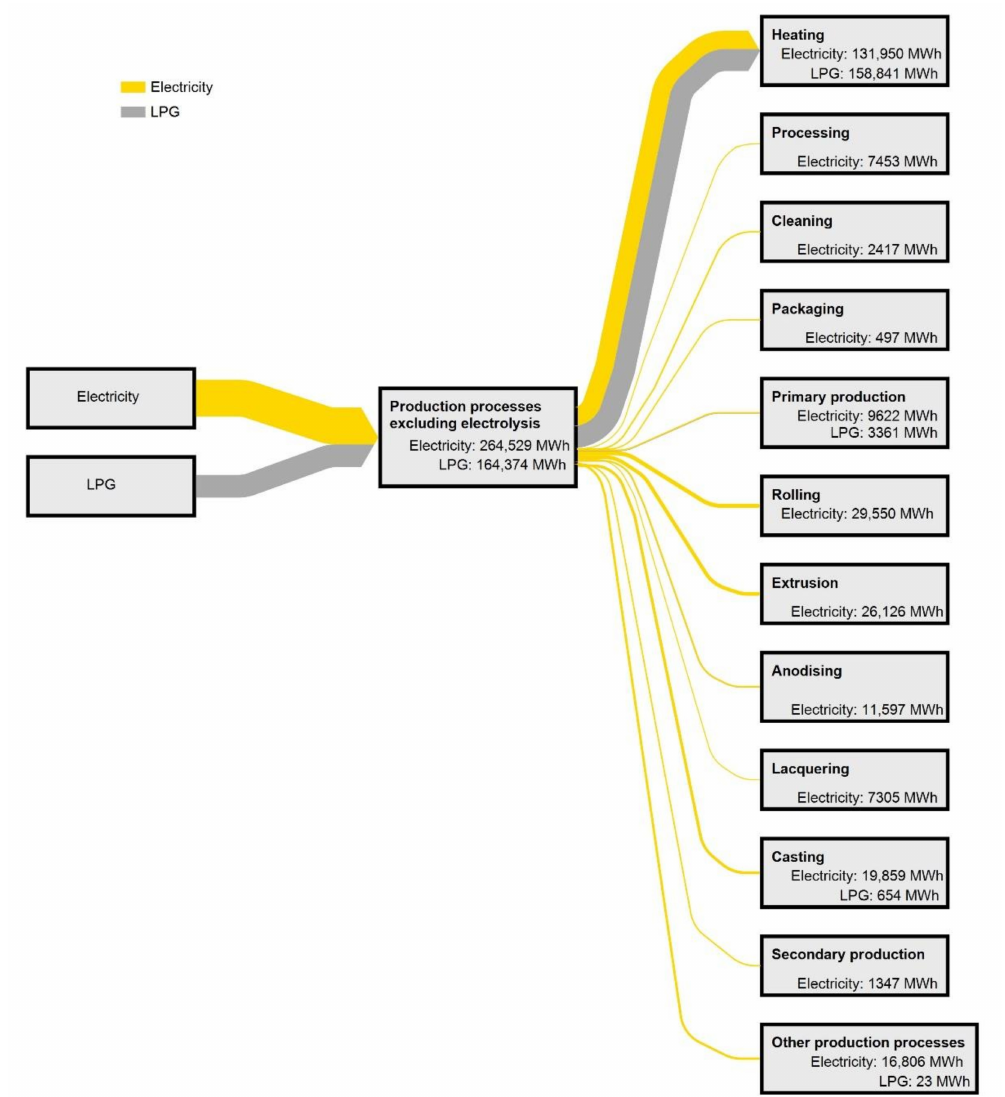
Figure 10. The energy end-use of the aluminium industry and two aluminium casting foundries in Sweden regarding production processes, divided into each main category. Electrolysis is excluded. Processes occurring at several companies in the supply chain have been combined into one entry